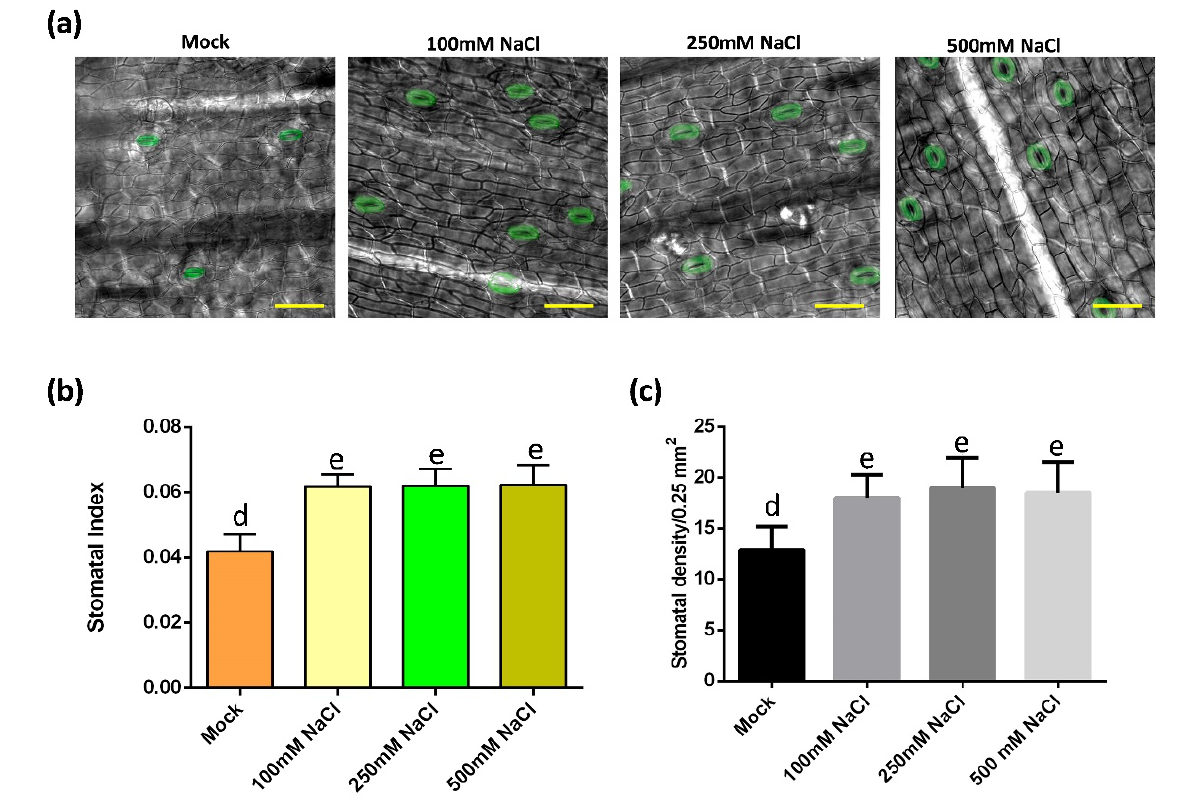
Figure 2. Salt stress activates stomatal production in oil palm. ( a ) Abaxial stomata of oil palm in mock and salt stress groups. Oil palm seedlings were treated with either water or NaCl solutions with 100 mM NaCl, 250 mM NaCl, 500 mM NaCl for 14 days respectively. Stomata are green colored. Scale bar = 30 µm. ( b ) Stomatal index of samples from ( a ). ( c ) Stomatal density of samples from ( a ). Values are mean ± SD; n = 20. One-way ANOVA with post-hoc Tukey HSD; p < 0.01. Samples were treated daily with 150 mL of either water (Mock) or NaCl for 14 days.